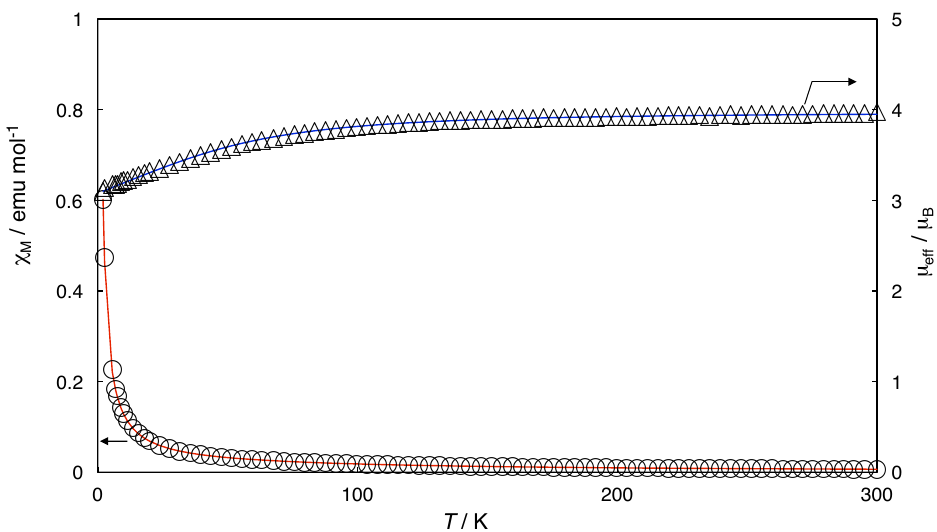
Figure 6. Temperature dependences of magnetic susceptibility χ M (circles) and moment µ eff (triangles) for n Bu 4 N[Ru 2 (O 2 CC 3 C 7 ) 4 Cl 2 ] ( 2 ). The red and blue solid lines were calculated and drawn with the parameter values described in the text.